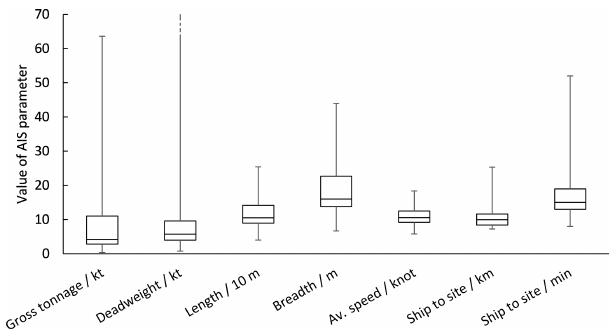
Figure 6. AIS ship information and calculated plume travel data for the 113 plumes evaluated from the winter campaign in Falsterbo. The boxes show the median, 25th percentile, and 75th percentile, and whiskers show the minimum and maximum value. The maxi- mum deadweight of 140kt is out of